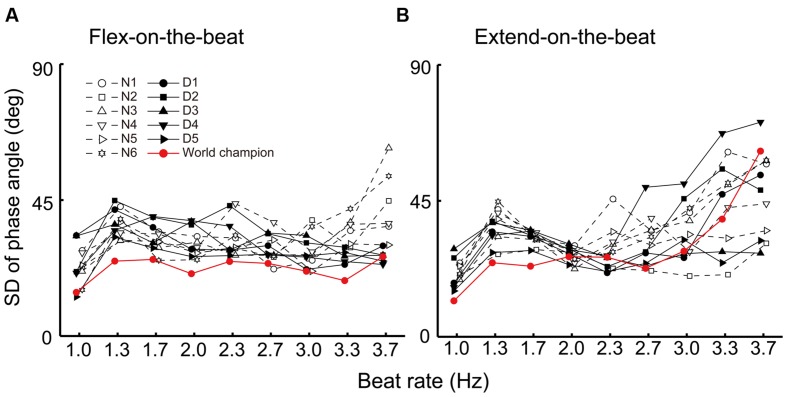
Standard deviation of the phase angle under the flex-on-the-beat (A) and the extend-on-the-beat (B) conditions. The data are plotted for each participant. The dashed line denotes the non-dancers, the solid line denotes the dancers, and the red line denotes the world champion.